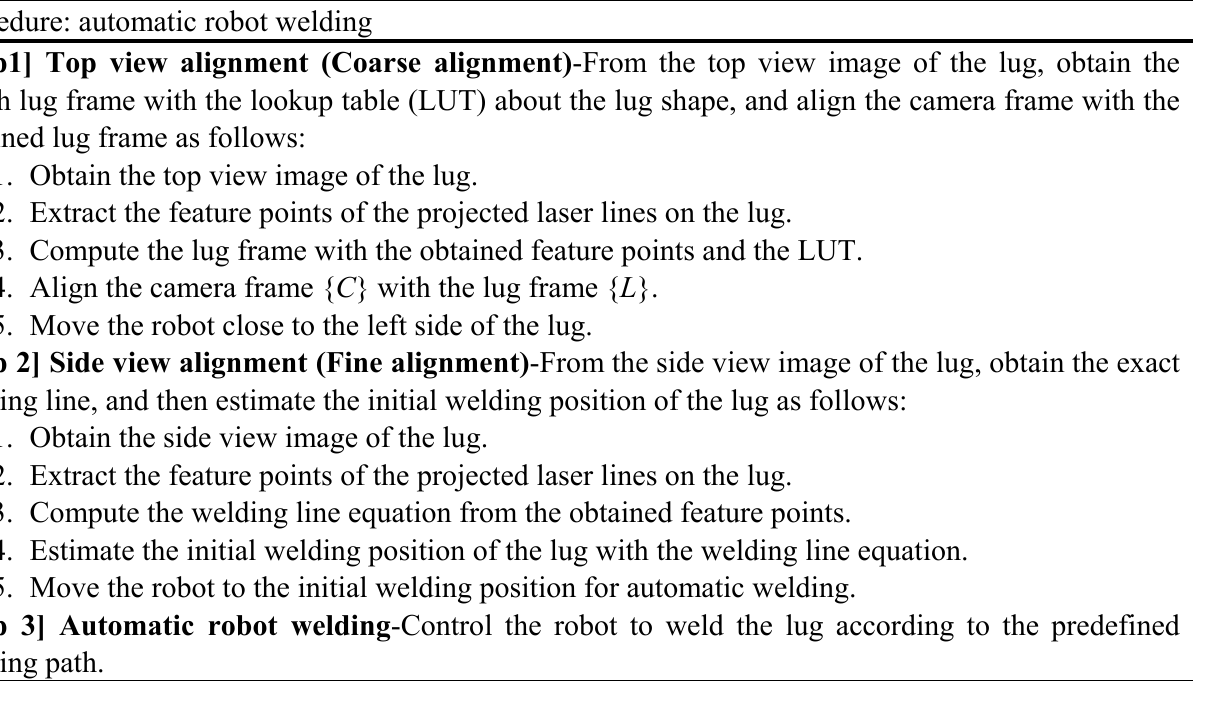
Table 1. Automatic robot welding